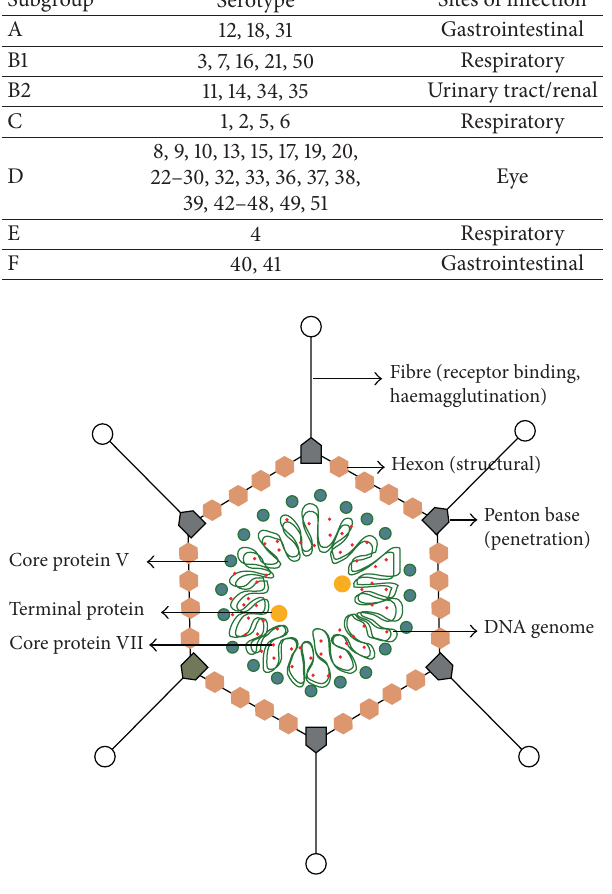
Figure 1: Structure of